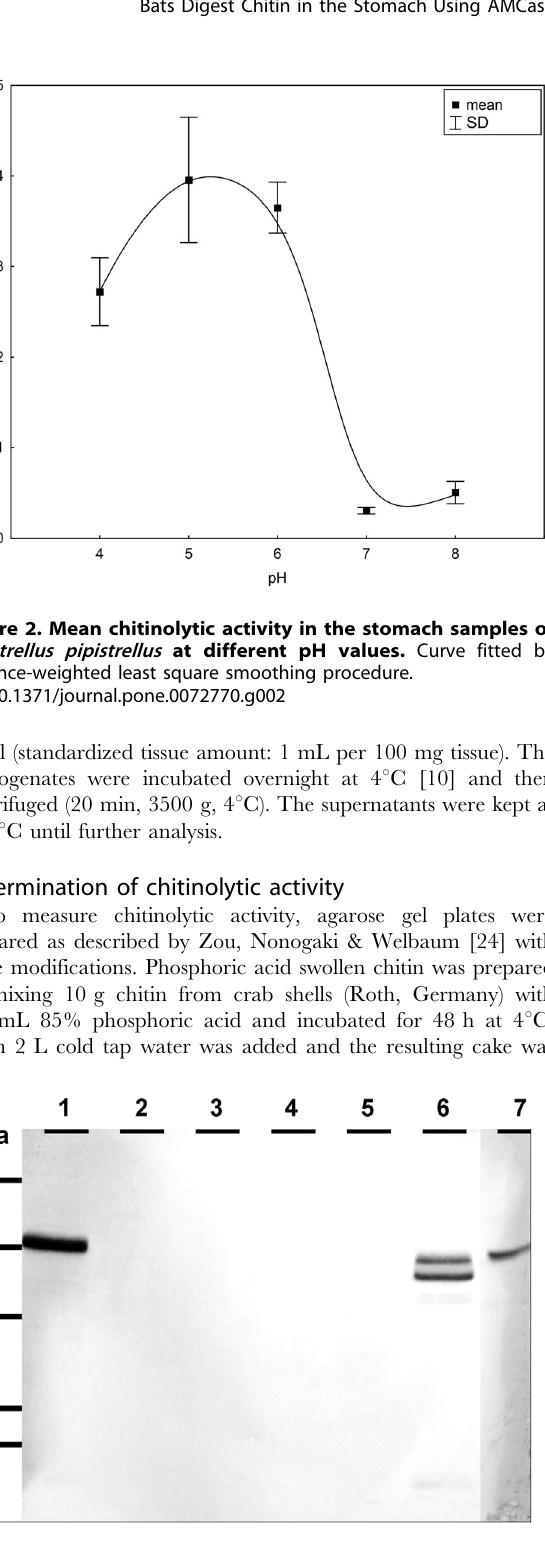
Figure 3. Exemplary western blot analysis of AMCase in the GI tract of Pipistrelluspipistrellus. Individual 1: lane 1= stomach, lane 2= duodenum, lane 3= jejunum/ileum, lane 4= ileum/colon, lane 5= colon/rectum; individual 2: lane 6= stomach; lane 7= positive control (stomach sample of Mus musculus ). The AMCase displayed a sharp band in the lane containing stomach proteins (46 k) except that lane 6 contained two distinct bands under 46 k probably caused by proteolytic digestion. Primary antibody dilution 1:1000.